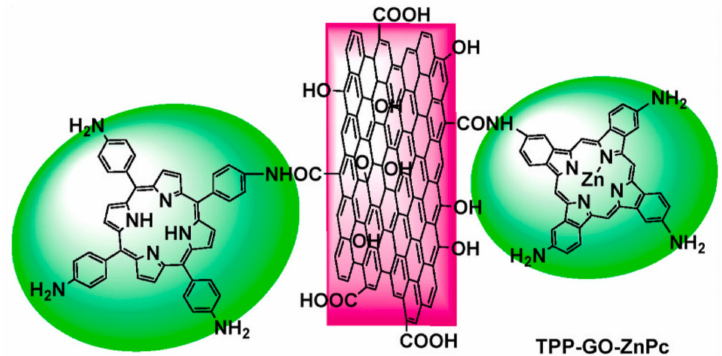
Figure 10. The configuration of TPP-GO-ZnPc (Reproduced with permission from ref. [60]. Copyright 2021 Elsevier Publications).